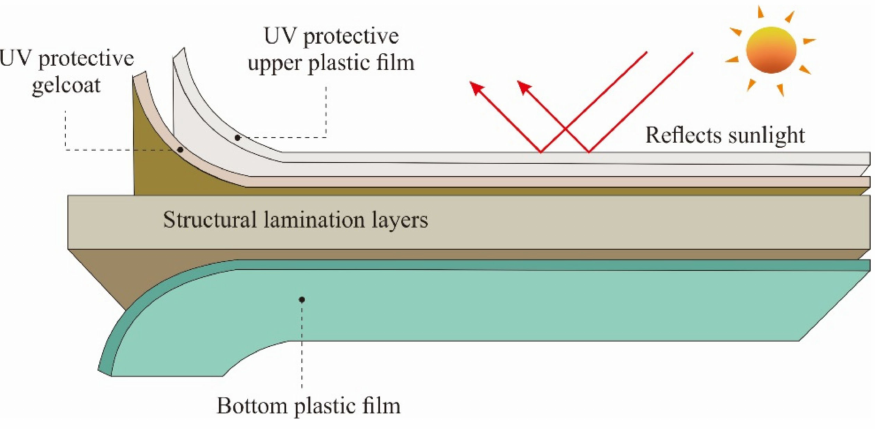
Figure 3. The layer structure of the GRFP